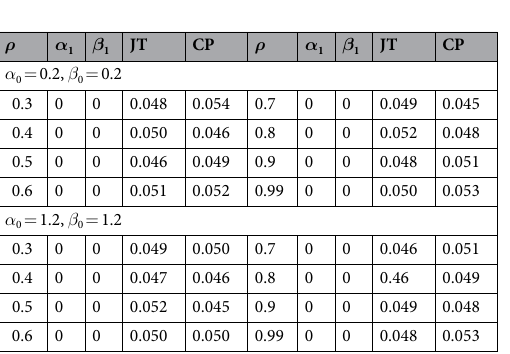
Table 1. Empirical type-1 error rates for tests JT and CP with 3 ordinal categories( k = 2).